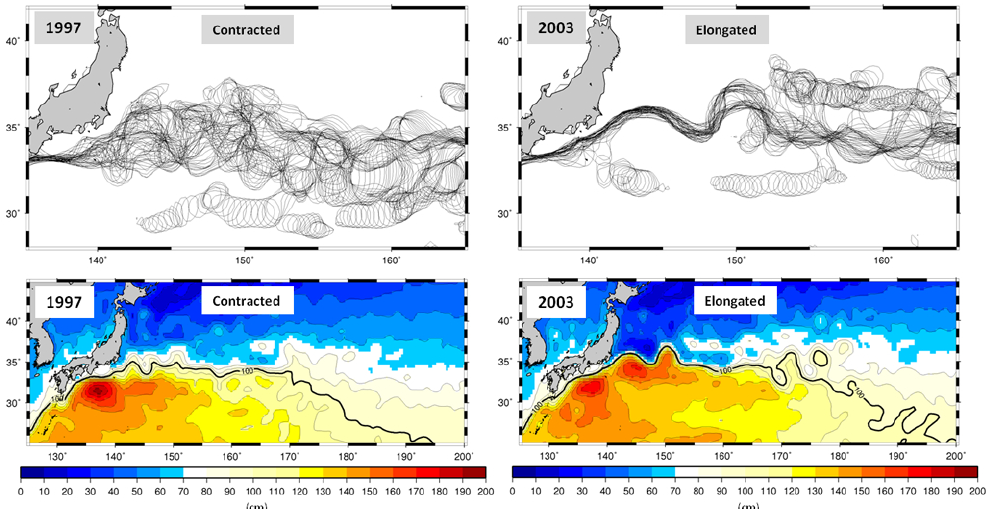
Fig. 3. Upper panels: yearly paths defined by the 100cm contours in the weekly ADT (Absolute Dynamic Topography) fields for the 1997 contracted state (left) and the 2003 elongated state (right). Lower panels: yearly averaged ADT with a 10cm contour interval and a thick line denoting 100cm in the KE region during year 1997 (left) and year 2003 (right).